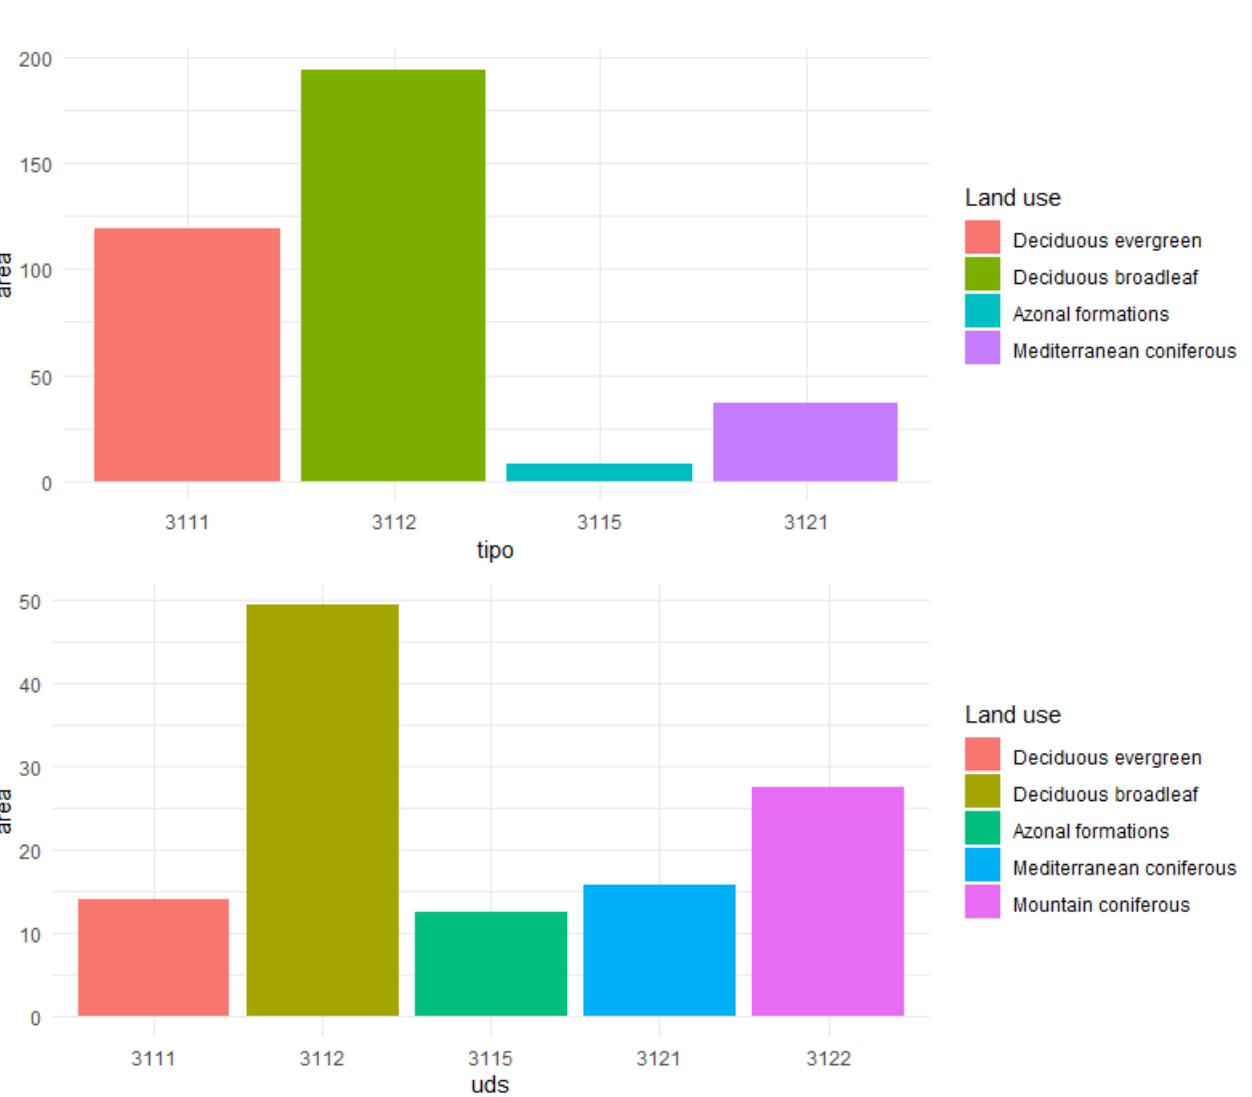
Figure 3. Distribution of forest types according to the reference dataset for the two study areas.